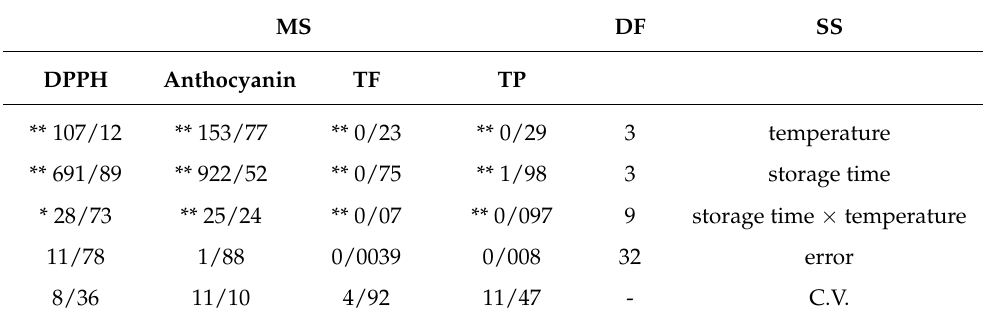
Table 3. ANOVA for the total phenolics, flavonoids, antioxidant capacity, and anthocyanin content in cornelian cherry fruits treated with 1% chitosan under storage with different temperatures. MS DF SS DPPH Anthocyanin TF TP ** 107/12 ** 153/77 ** 0/23 ** 0/29 3 temperature ** 691/89 ** 922/52 ** 0/75 ** 1/98 3 storage time * 28/73 ** 25/24 ** 0/07 ** 0/097 9 storage time × temperature 11/78 1/88 0/0039 0/008 32 error 8/36 11/10 4/92 11/47 - C.V. * and ** indicate significant differences at 5% and 1% probability levels, respectively. TP = total